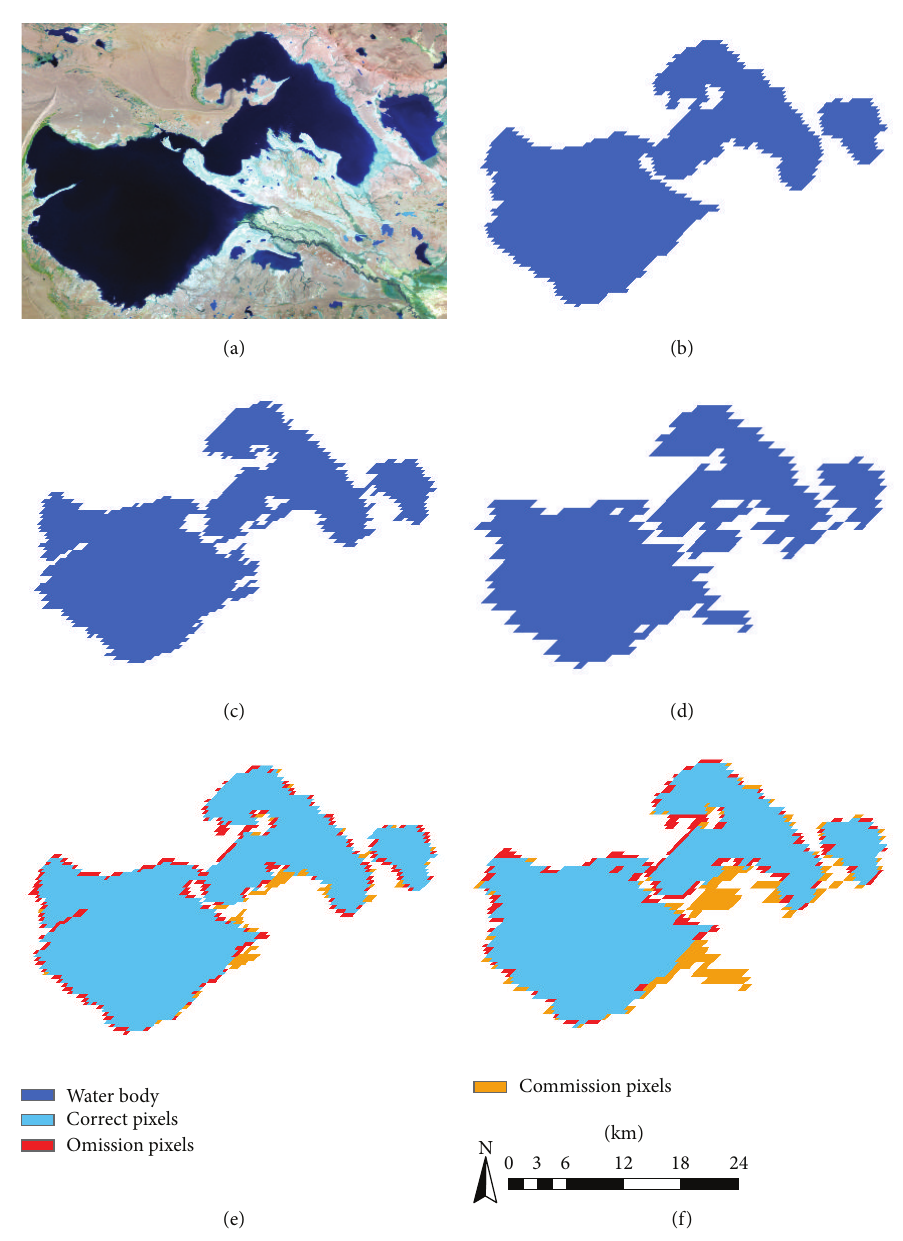
Figure 8: Visual performance in extracted water bodies and spatial errors for Co Bangkog; October 7, 2000. (a) Landsat-7 ETM+ 543 band false-color image; (b) aggregated reference water map from ETM+ image; (c) extracted result from downscaled image at 250 m; (d) extracted result from original image at 500 m; (e) result of spatial error for (c) map; (f) result of spatial error for (d)